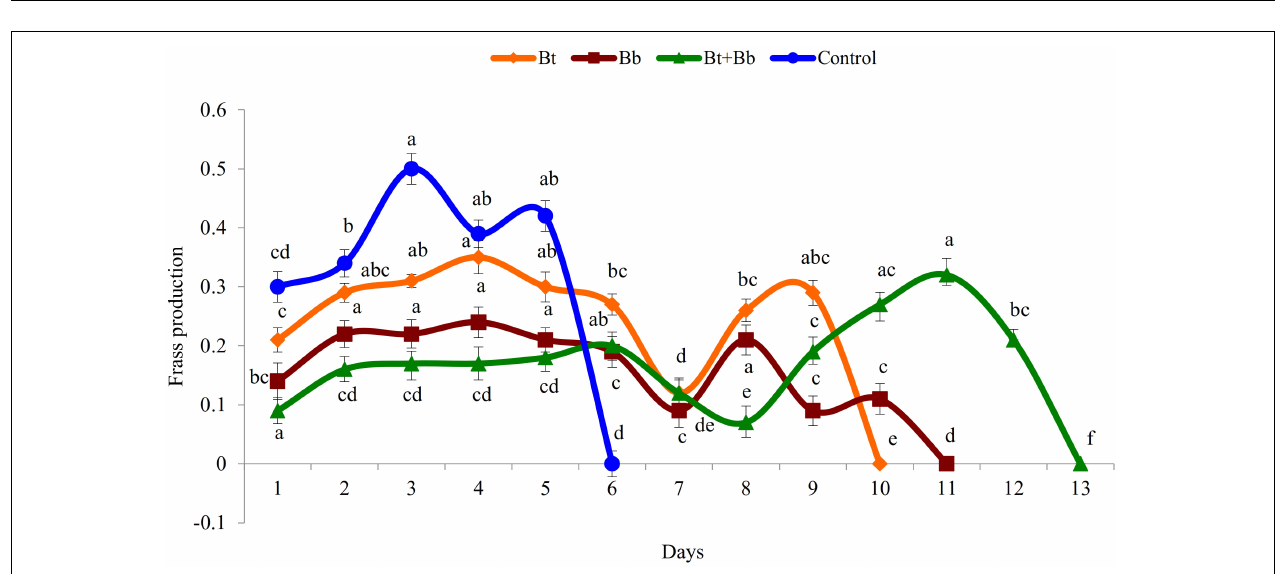
FIGURE 2 | Diet consumption (g) in last instar H. armigera treated with endophytic B. bassiana (Bb: 1 × 10 5 conidia ml − 1 ) alone and in combination with B. thuringiensis (Bt1: 0.20 µ g ml − 1 ). Means followed by the same letter within each treatment are not significantly different; HSD test P ≤ 0.05.